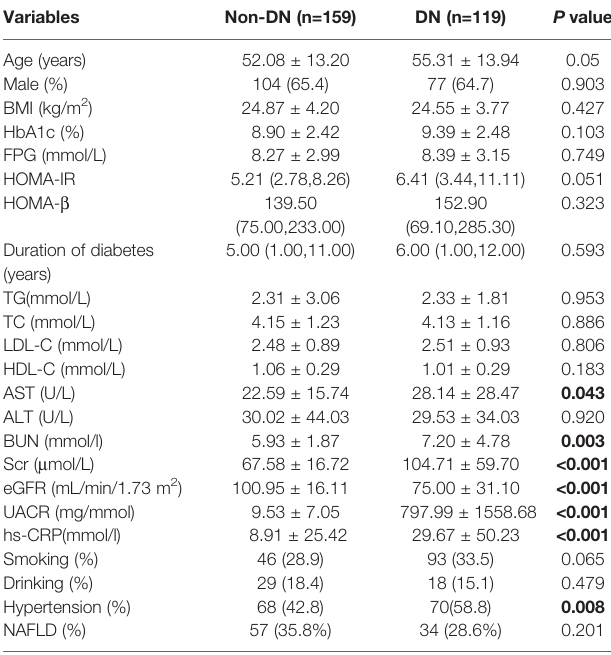
TABLE 1 | Anthropometric and biochemical characteristics of participants.